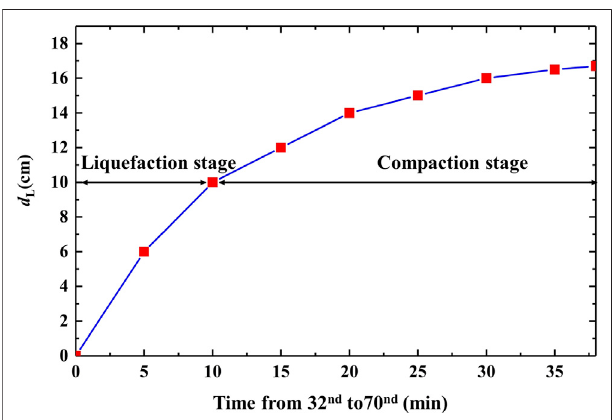
FIGURE 10 | Distance between the rightmost end of the liquefaction interface and the out fl ow location of the WILSGF.